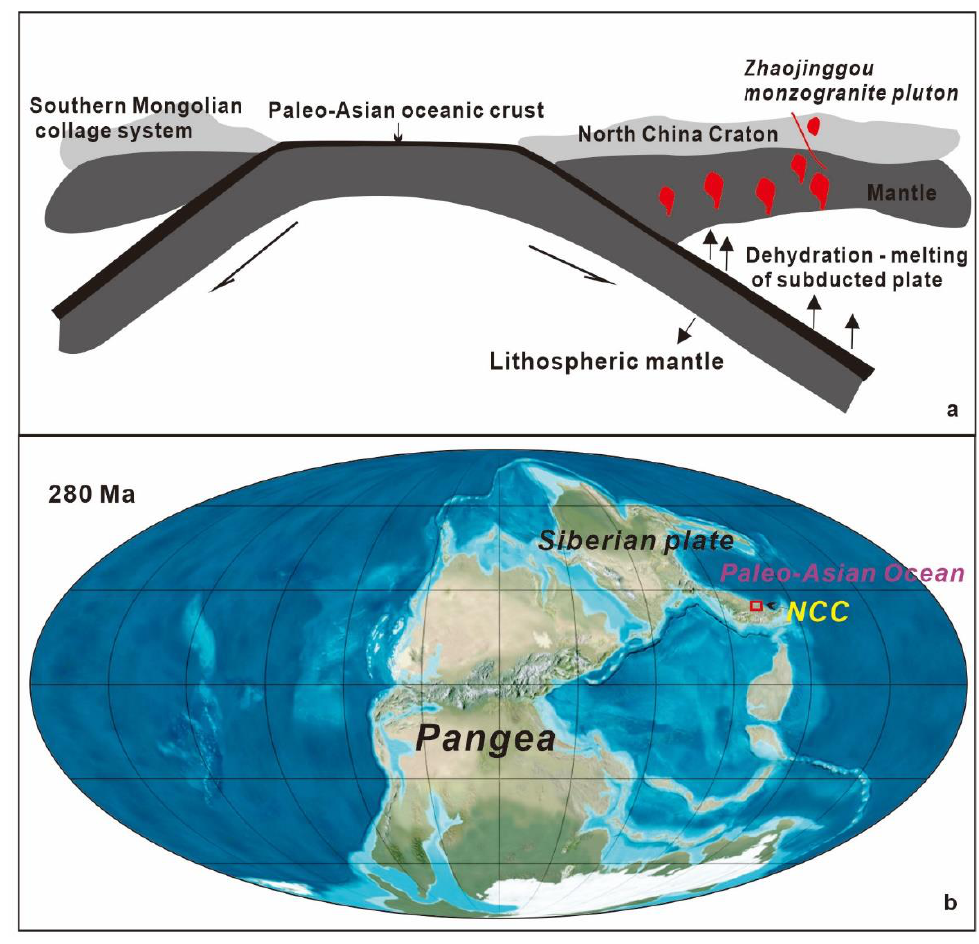
Figure 8. ( a ) Schematic diagram of the tectonic setting for the Zhaojinggou area in the northern NCC during the Early-Middle Permian (modified from [1,6,40]). ( b ) The Paleogeographic earth reconstruction, Early Permian (modified from [41]).